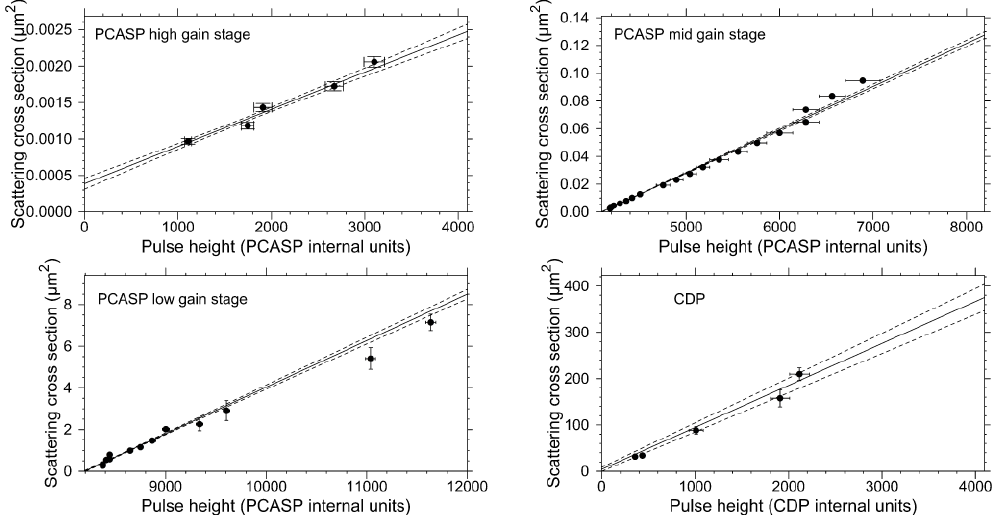
Fig. 4. Particle scattering cross section as a function of pulse height for an example calibration of the PCASP and CDP. The points represent the modes of size distributions generated from calibration particles with scattering cross sections defined by Eq. (4). The uncertainties in the horizontal direction are defined as half the OPC resolution and those in the vertical direction are defined by Eq. (5). The solid line shows the best fit straight line when uncertainties on both axes are utilised dashed line shows the standard error of the best